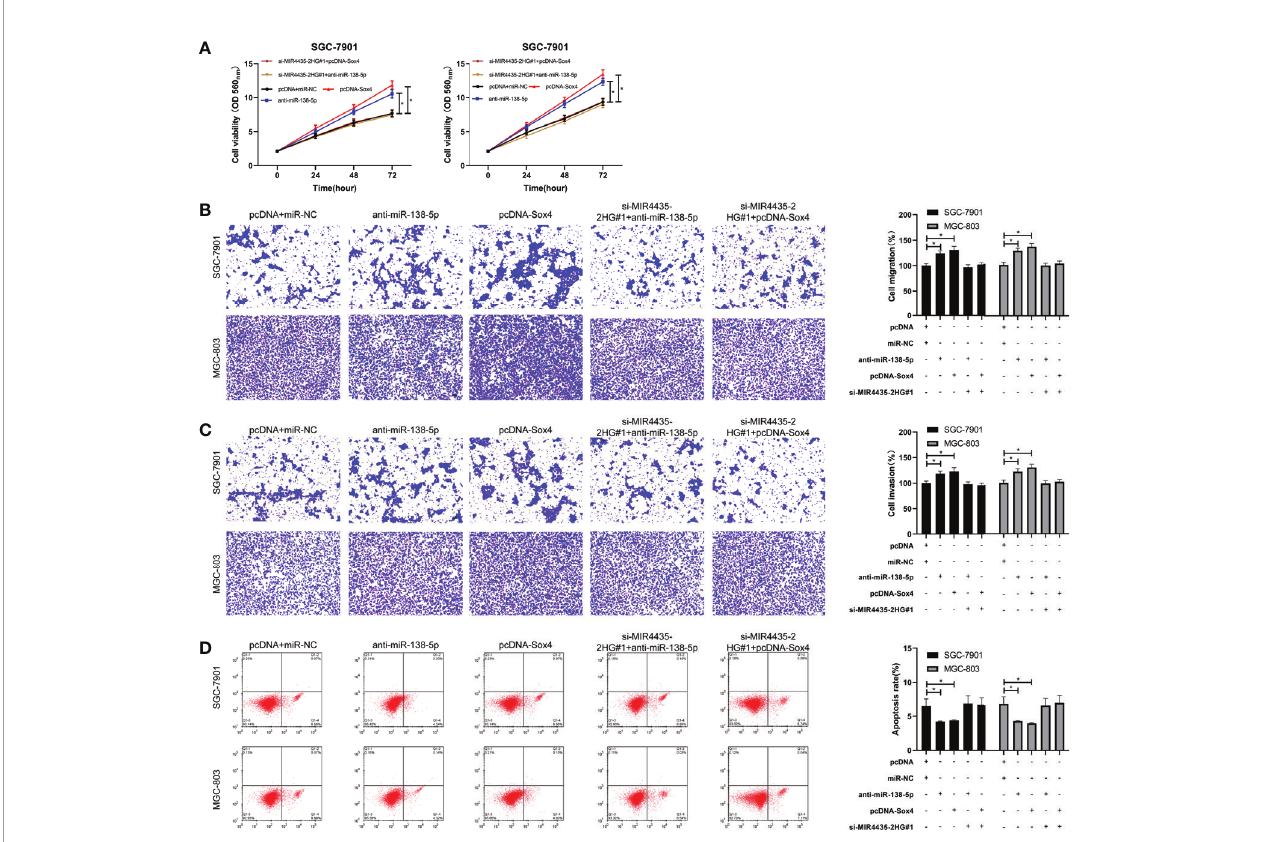
FIGURE 5 | MIR4435-2HG inhibited the growth, metastasis, and epithelial – mesenchymal transition (EMT) of gastric carcinoma cells by mediating miR-138-5p/Sox4 axis. (A) Cell Counting Kit-8 (CCK-8)-8 test was applied to test cell proliferation after co-transfection of si-MIR4435-2HG#1 with anti-miR-138-5p and pcDNA-Sox4 in SGC-7901 and MGC-803 cells. (B, C) Transwell test was applied to test cell invasion and migration after co-transfection of si-MIR4435-2HG#1 with anti-miR-138- 5p and pcDNA-Sox4 in SGC-7901 and MGC-803 cells. (D) Flow cytometry was applied to test the cell apoptosis after co-transfection of si-MIR4435-2HG#1 with anti-miR-138-5p and pcDNA-Sox4 in SGC-7901 and MGC-803 cells. Western blotting (WB) was applied to test E-cadherin, vimentin, and fi bronectin after co- transfection of si-MIR4435-2HG#1 with anti-miR-138-5p and pcDNA-Sox4 in SGC-7901 and MGC-803 cells. * indicates p <